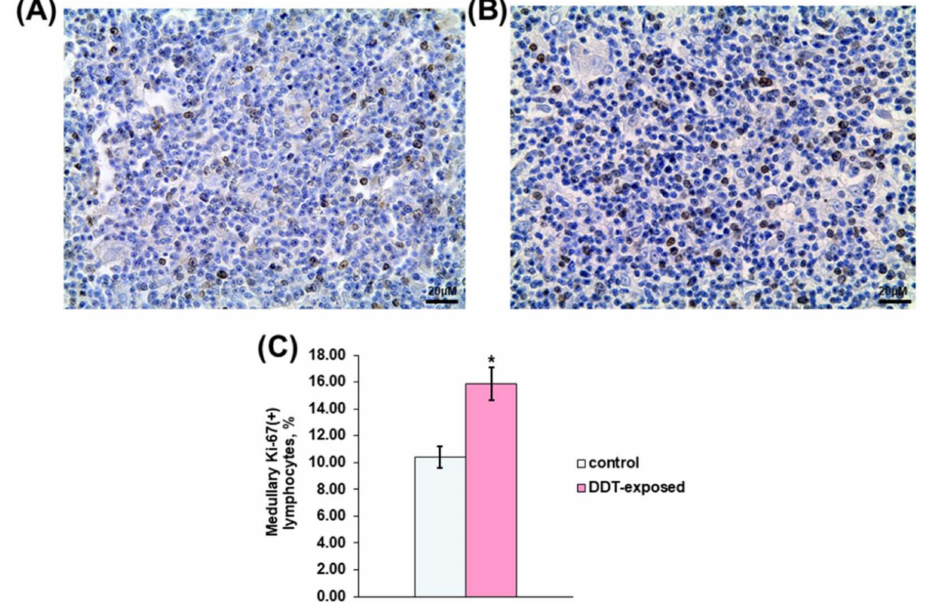
Figure 4. Immunohistochemical evaluation of Ki-67-positive medullary lymphocytes in prenatally and postnatally exposed to DDT and intact adult rats aged 10 weeks. Distribution of proliferating thymocytes in the control ( A ) and DDT-exposed ( B ) rats. Magnification 400, scale bar 20 µ m. Percent- age of Ki-67-positive thymocytes in the cortex ( C ). Data presents as mean ± S.E.M. p < 0.05 compared to the control